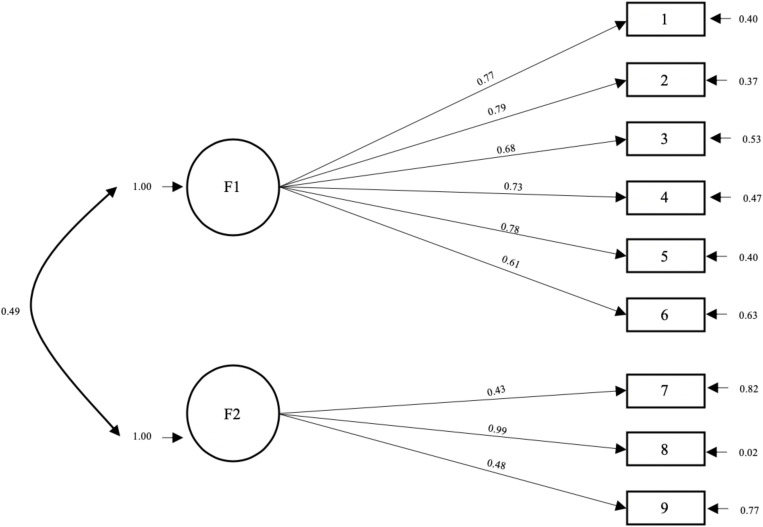
Overview of the confirmatory factorial analysis results.